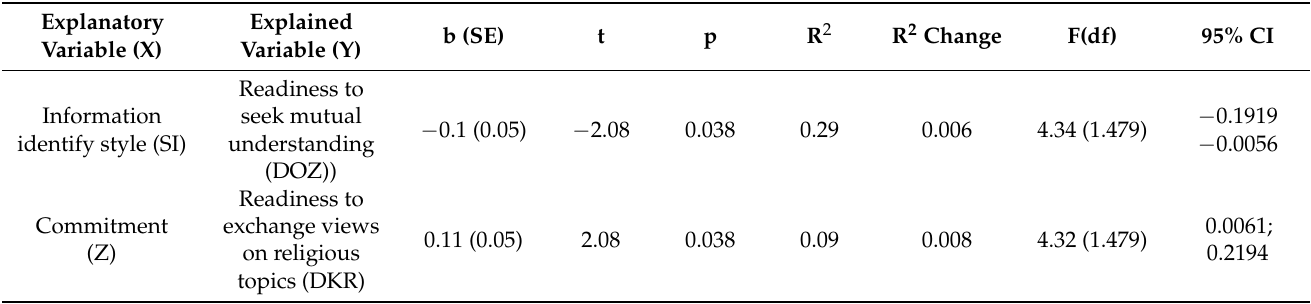
Table 4. Organized religiousness as a moderator of the relationships between identity styles and readiness to enter into interreligious